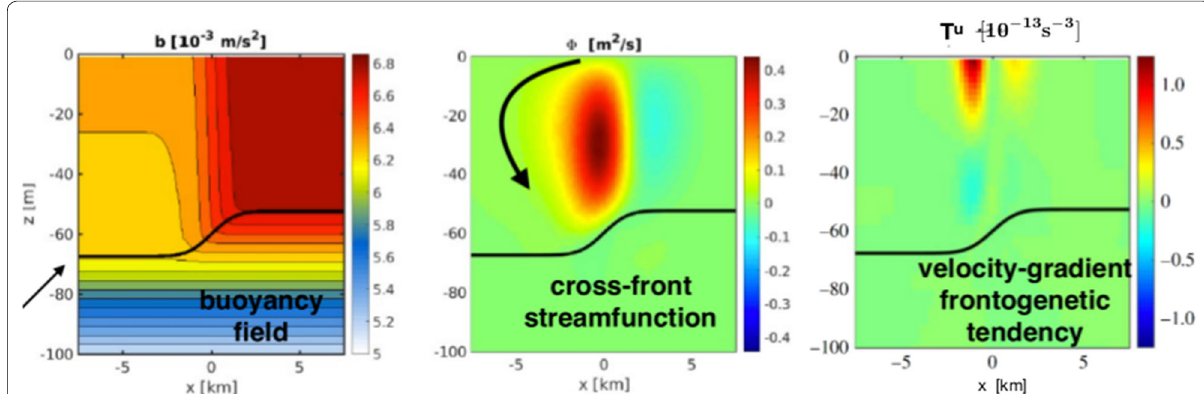
Fig. 8 Frontogenesis by turbulent thermal wind (TTW). The buoyancy field b (left), ageostrophic secondary-circulation streamfunction (cid:31) (center), and Lagrangian, velocity-gradient frontogenetic tendency, T u = D |∇ u | 2 / Dt [10 − 13 s − 3 ] (right), for an idealized 2D surface front with vertical mixing (McWilliams 2017). The thick black line, pointed to by the arrow on the left panel, is the boundary-layer depth, and the curved line in the center panel indicates the direction of the secondary circulation. The horizontal convergence on the dense side near the surface (i.e., the upper left region in the buoyancy b ( x , z ) in left panel induces frontogenesis in both ∇ b and ∇ u